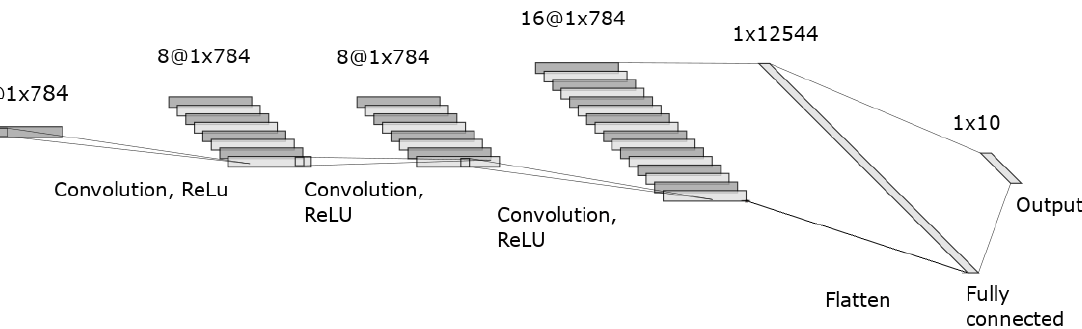
Figure 5. The architecture of our reference neural network model. Our network contained three convolutional layers with ReLUs followed by a fully connected layer. This simple four-layered architecture is capable of solving simple classification